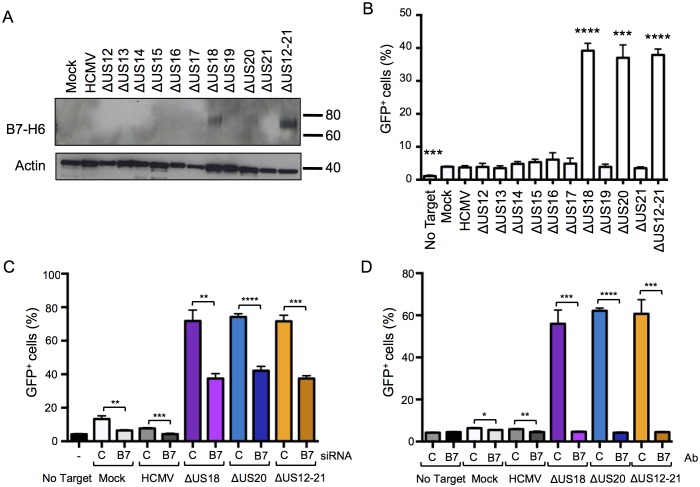
Differences in B7-H6 levels on HCMV US12 family deletion mutant-infected cells regulate NKp30-mediated responses.(A) Whole cell lysates were prepared from mock, HCMV or the series of US12 family deletion mutant infected fibroblasts and analyzed by immunoblotting with antibodies specific for B7-H6 (CH31) or actin. Results are representative of two independent experiments. (B) An NKp30-responsive 2B4 reporter cell line containing a NFAT-GFP reporter construct (CT299) was incubated for 24 hr with mock, HCMV or the series of US12 family deletion mutant infected fibroblasts in triplicate. Fixed cells were then analyzed for GFP fluorescence by flow cytometry compared to cells incubated with no target fibroblasts. Results are expressed as the % GFP positive reporter cells (mean and SD) and were analyzed by unpaired two-tailed Student’s T-test. Results are representative of two independent experiments. (C) HF-TERTs were transfected with control (C) or B7-H6 (B7) siRNAs for 24 hr prior to infection with the parent HCMV, △US18, △US20 or △US12-21 mutants for 72 hr. Cells were then incubated for 24 hr with CT299 NKp30 reporter cells in triplicate and GFP+ cells determined by flow cytometry, and analysed by unpaired two-tailed Student’s t-test. Results (mean and SD) are representative of two independent experiments. (D) HF-TERTs infected with HCMV, △US18, △US20 or △US12-21 mutants were incubated for 24 hr with CT299 NKp30 reporter cells, in the presence isotype control (C) or B7-H6 blocking antibodies (B7) in triplicate, GFP+ cells determined by flow cytometry and analyzed by unpaired two-tailed Student’s t-test. Results (mean and SD) are representative of two independent experiments.